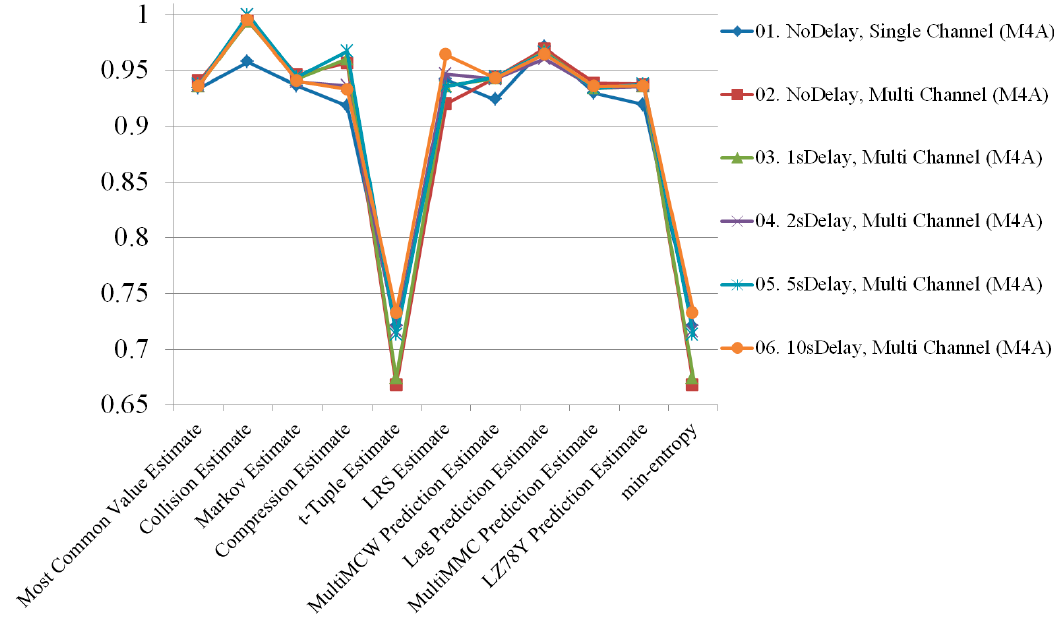
Figure 10. Randomness comparison results of the M4A file format generated from radio signals collected under all conditions.